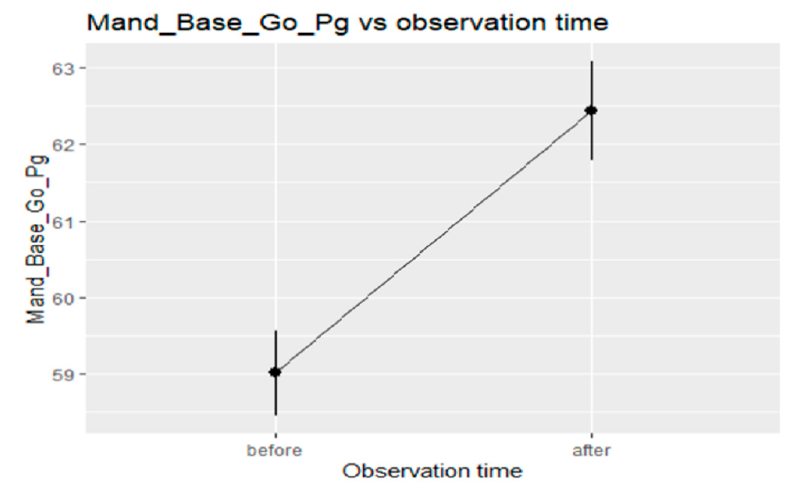
Figure 11. Trend in Go-Pg over time from T0 to T1.